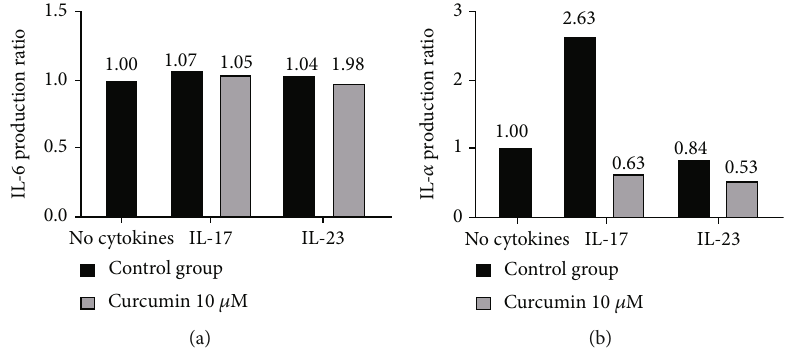
Figure 8: (a) Comparison of IL-6 production in SW982 cells after 24 h incubation with IL-17 or IL-23 with or without addition of 10 μ M curcumin measured by multiplex analysis. (b) Comparison of TNF- α production in SW982 cells after 24 h incubation with IL-17 or IL-23 (at 50ng/ml) with or without addition of 10 μ M curcumin measured by multiplex analysis. Data are presented from one experiment conducted from two wells.